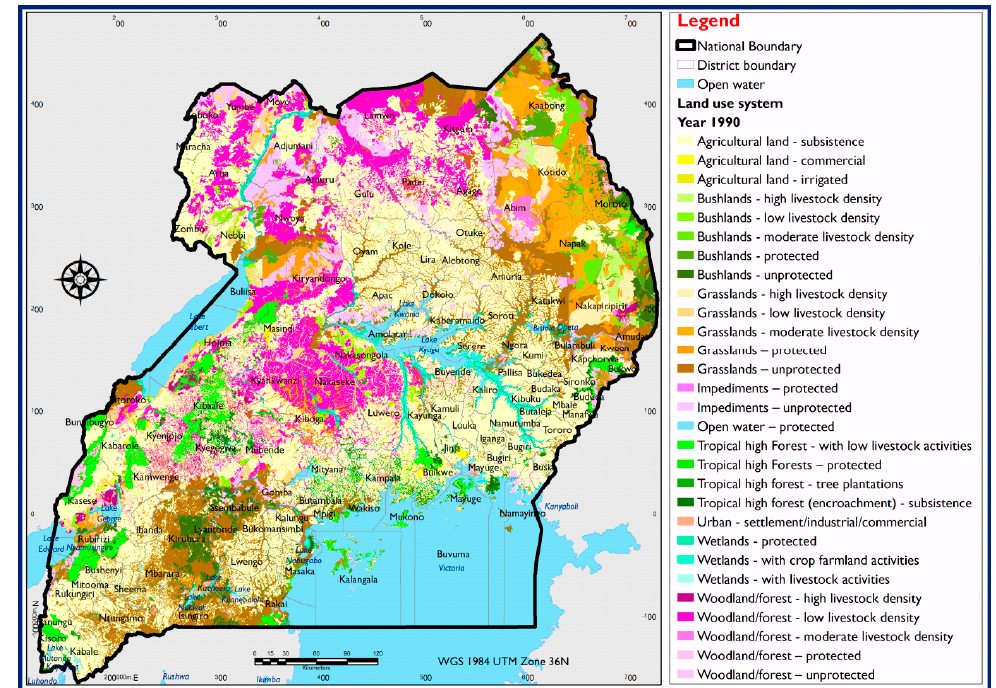
Figure 4. Historical land use systems of Uganda in 1990.